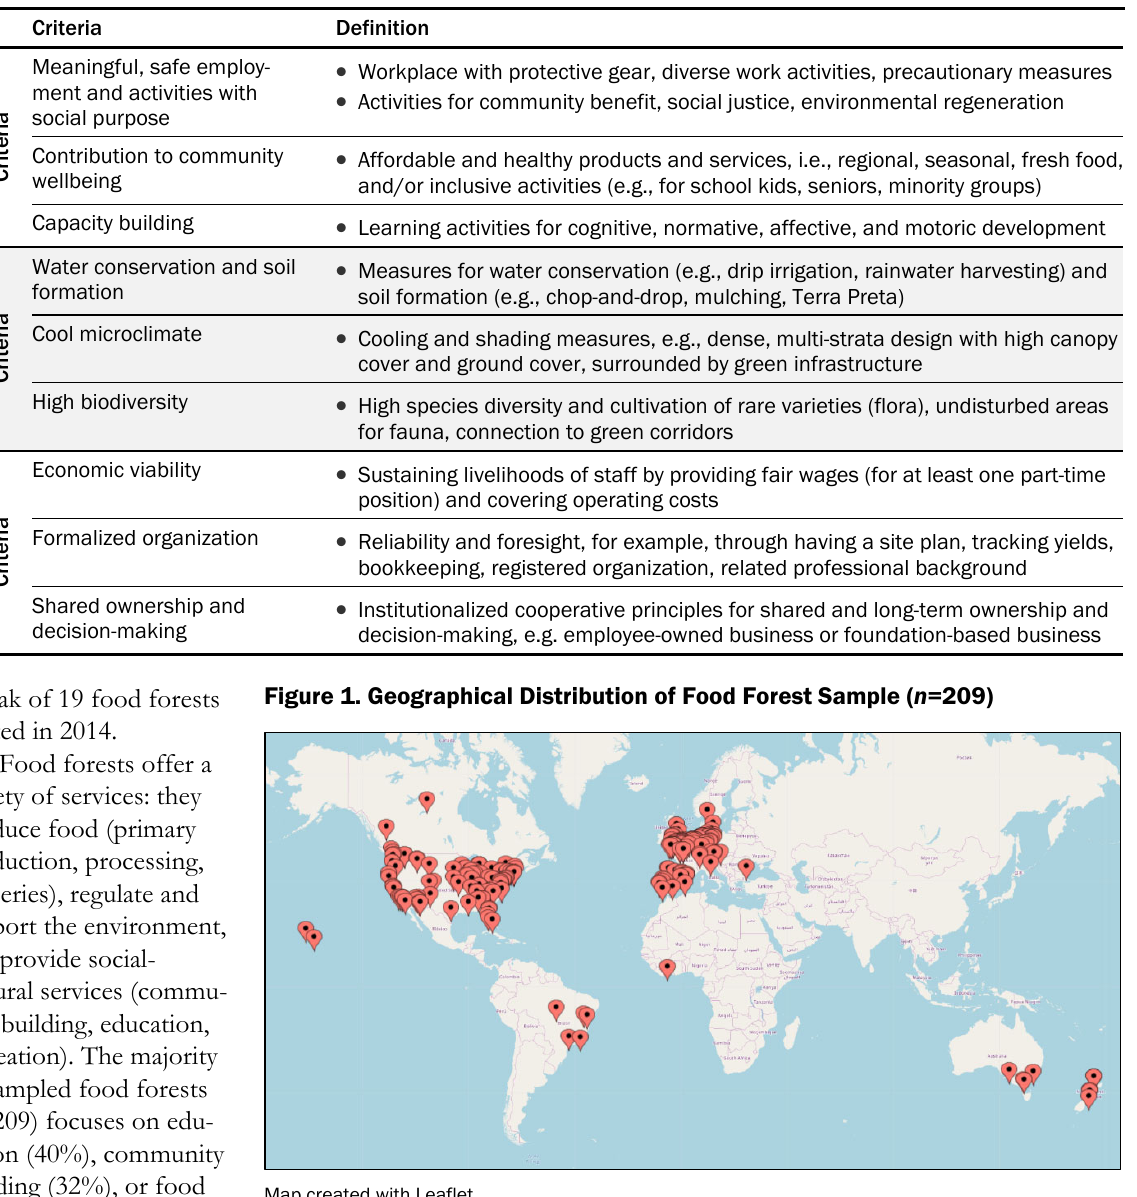
Map created with